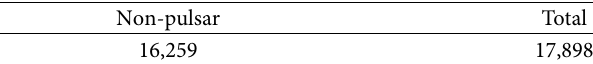
Table 2: Number of samples in HTRU2 dataset.